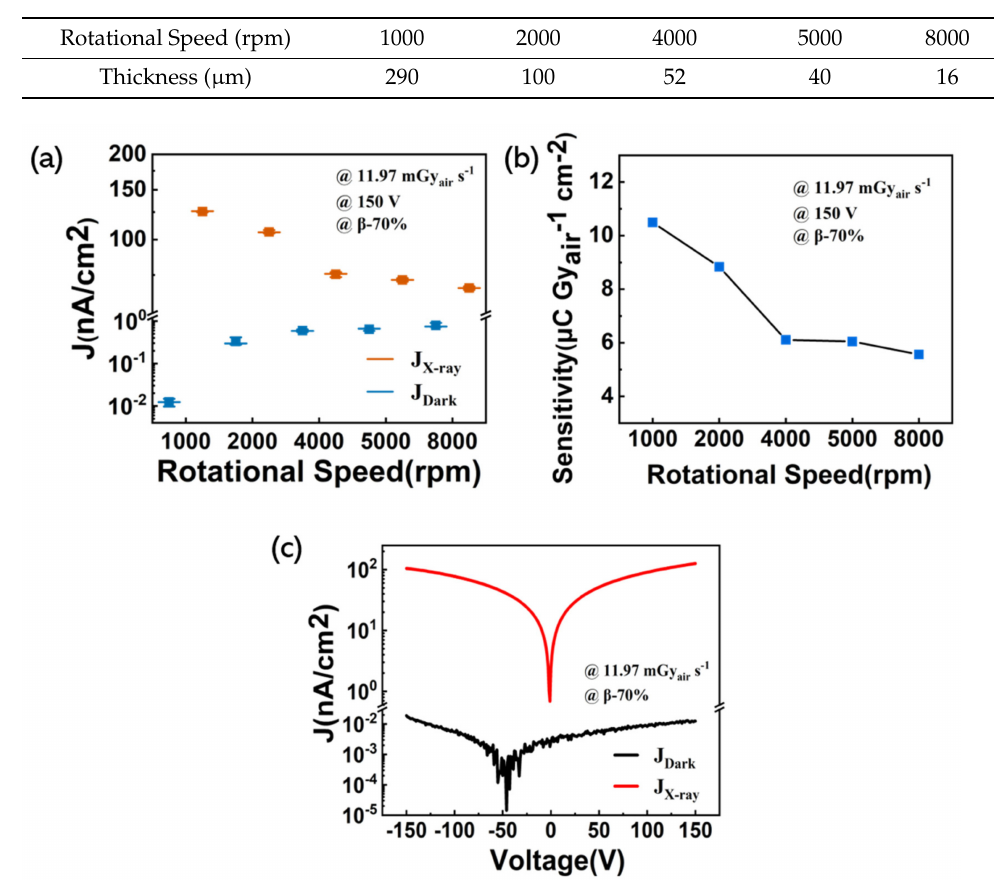
Table 2. Correspondence between spin coating speed and thickness.